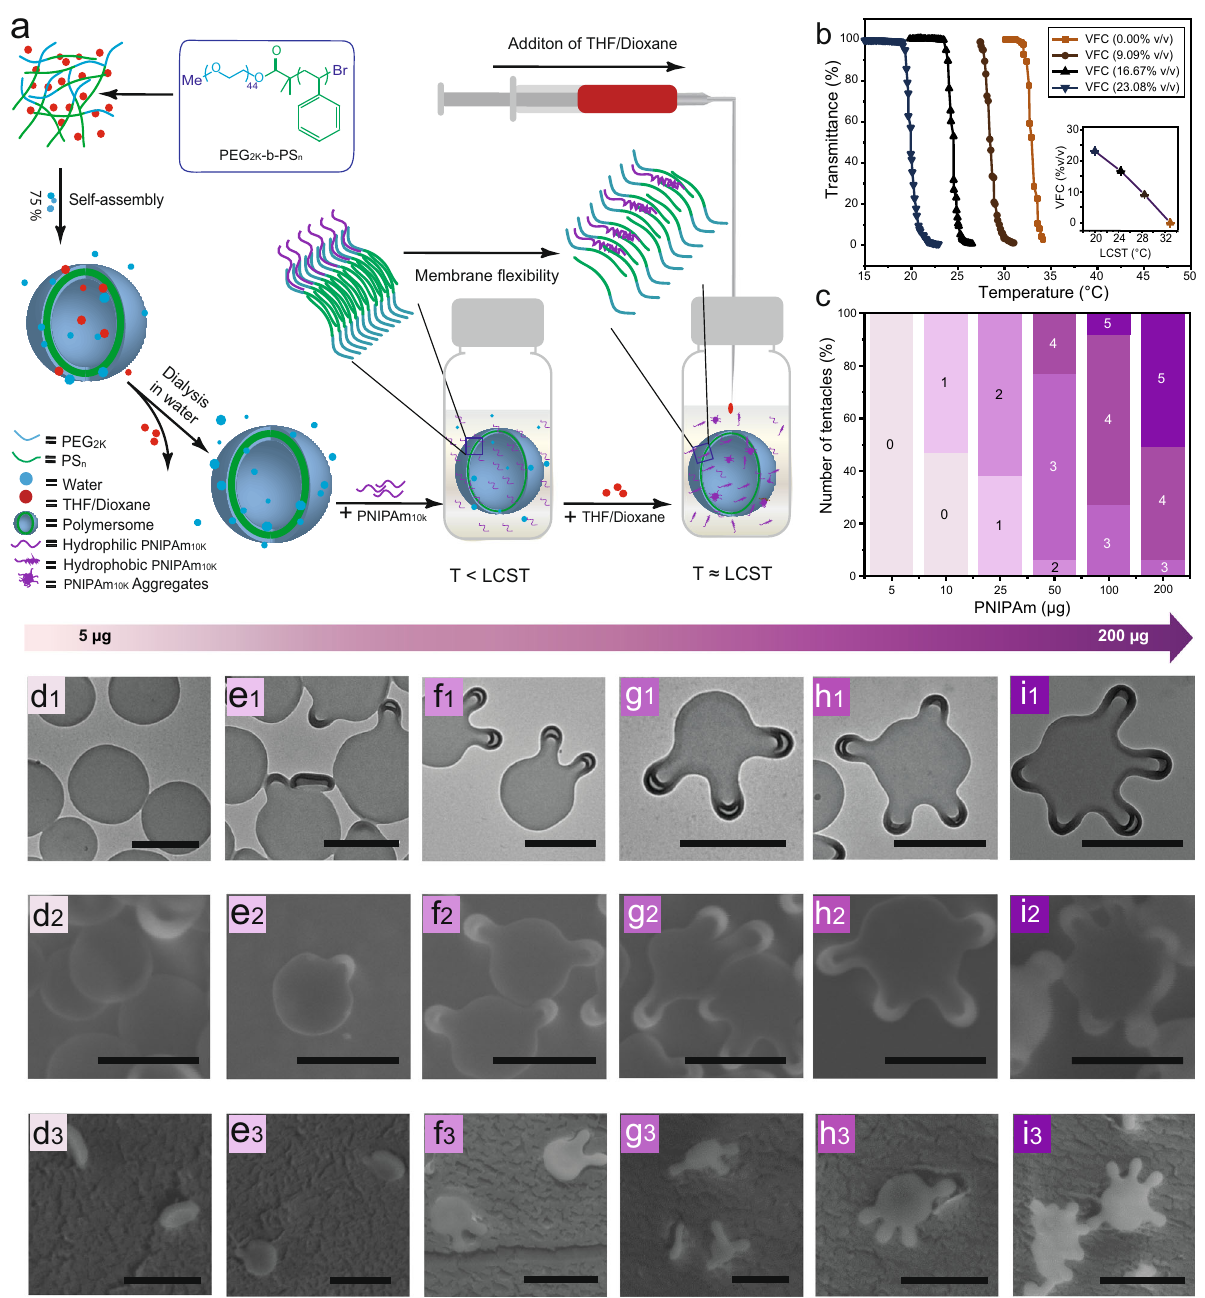
Fig. 2 Curvature formation of polymersomes via PNIPAm insertion. a Schematic representation of the curvature formation of polymersomes. The variation of LCST of PNIPAm in the volume fraction of water-cononsolvent (THF:Dioxane = 4:1) detected by UV – vis spectroscopy ( b ). The relation between increase of formed tentacles and the PNIPAm concentration. 100 particles were analyzed from each sample ( c ). TEM(d1-i1), SEM ( d 2- i 2), Cryo- SEM ( d 3- i 3) images depicting the formation of the polymersome membrane curvature during an increase of the PNIPAm concentration (5 µ g, 10 µ g, 25 µ g, 50 µ g, 100 µ g and 200 µ g). Samples were quenched after addition of 23.08% organic solvent. Scale bar 500